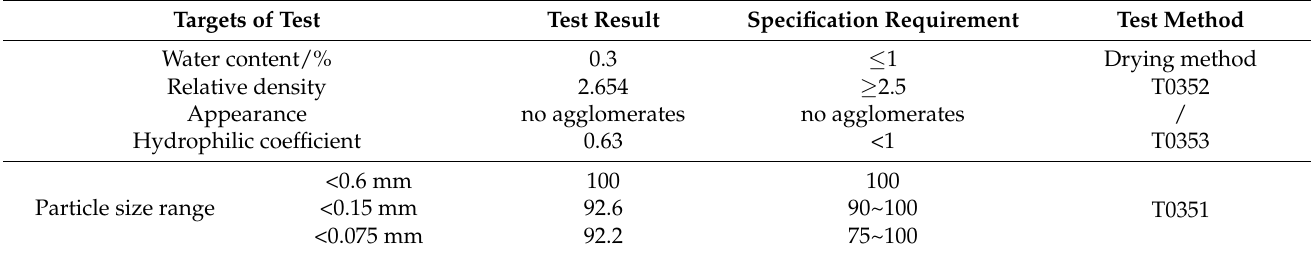
Table 4. Technical indexes of mineral fillers.